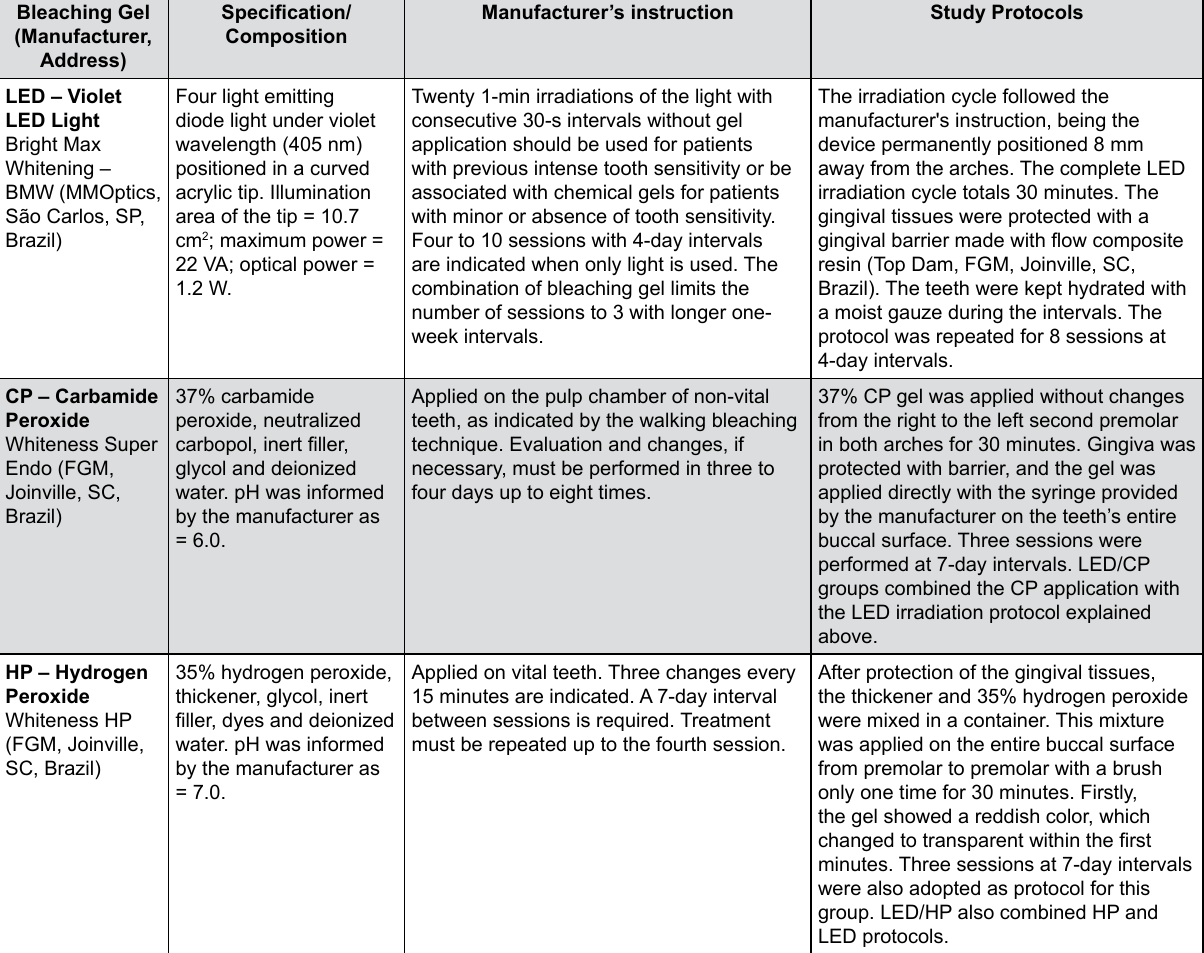
Figure 1- Bleaching gels, composition, light source, manufacturer’s instructions, and study